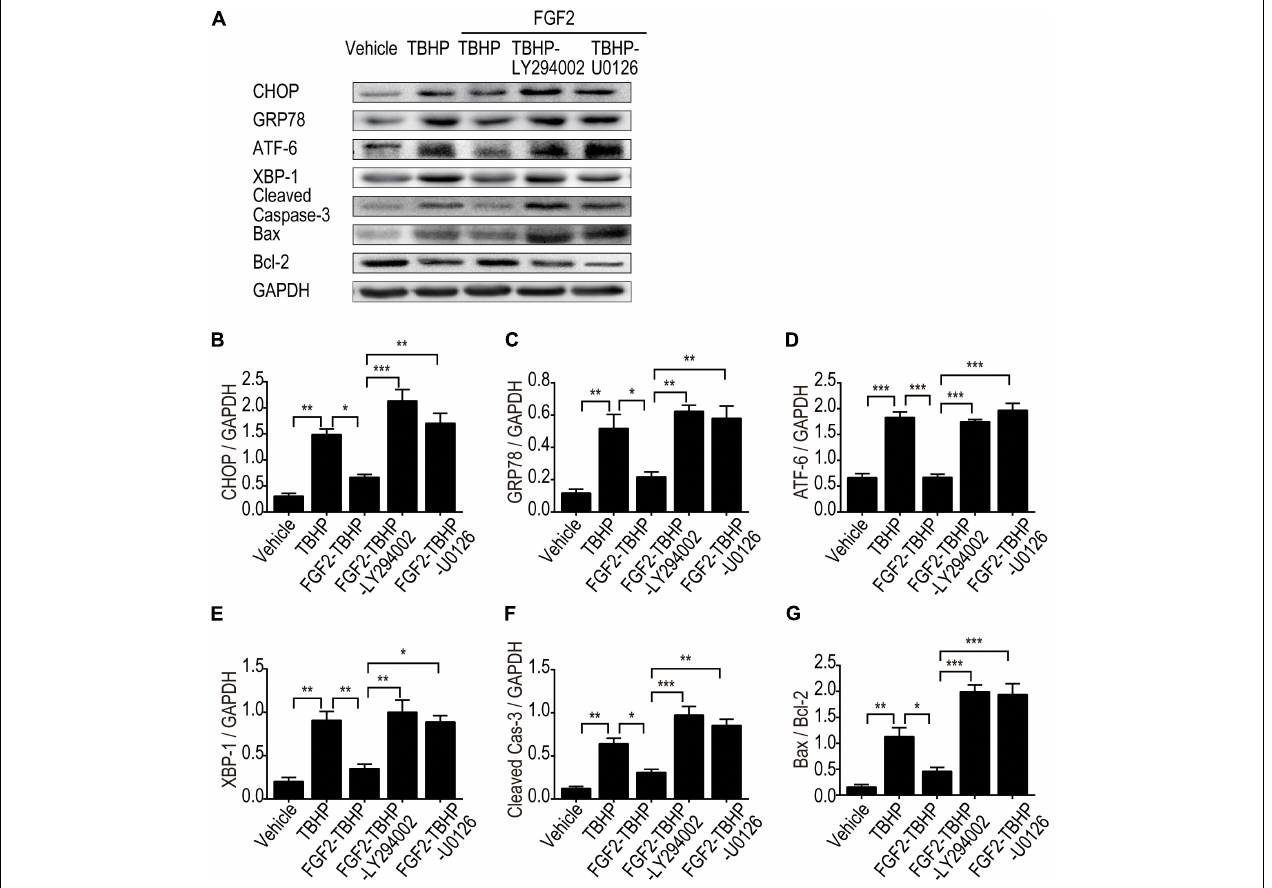
FIGURE 8 | LY294002 and U0126 abolish the effect of FGF2 on the inhibition of ER stress and apoptosis in vitro . (A) The expression of ER stress-relevant proteins and pro-apoptotic proteins were detected by Western blotting. Images are representative of five animals in each group. (B–G) The histograms show the normalized optical density analysis. Both LY294002 and U0126 could largely suppress the effect of FGF2 on apoptosis and ER stress. Representative data of five individual samples in each group. * P < 0.05, ** P < 0.01, *** P <